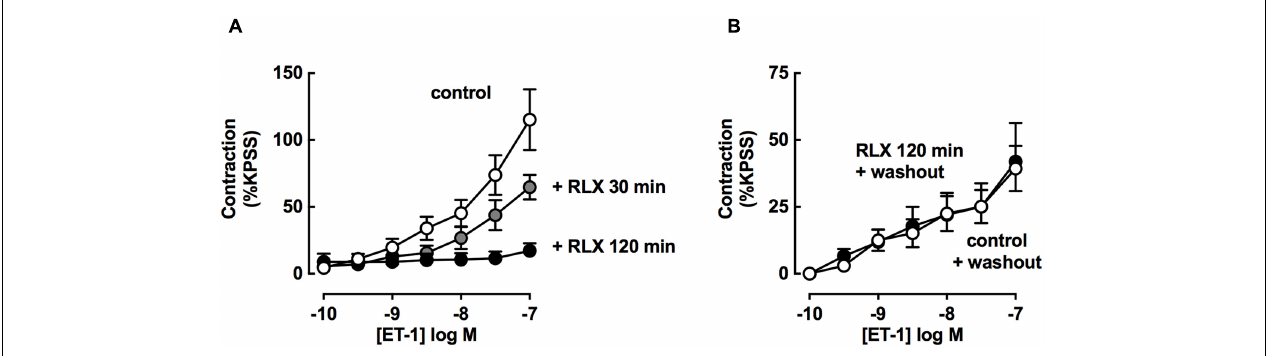
FIGURE 6 | rhRLX-mediated inhibition of tracheal contraction is increased with time and dependent on released factors. ET-1-induced contractions were assessed (A) in the absence or presence of rhRLX (RLX, 0.1 µ M) following pre-treatment with for 30 and 120 min and (B) in the absence of RLX following 120 min in the absence or presence of RLX (0.1 µ M) followed by replacement of the bathing solution. All responses are expressed as % KPSS standard contraction (mean ± SEM, n = 4–7 per